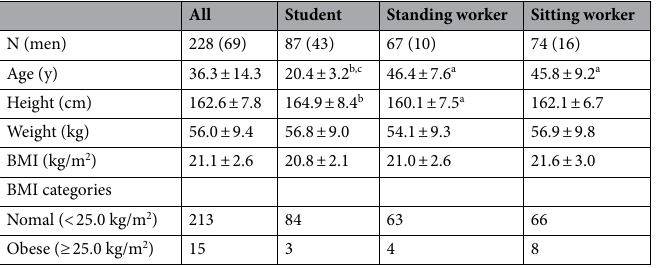
Table 1. Participant characteristic. BMI body mass index; vs. versus. Values are expressed as the mean ± standard deviation. a: p < 0.05 vs. Student group. b: p < 0.05 vs. Standing worker group. c: p < 0.05 vs. Sitting worker group.